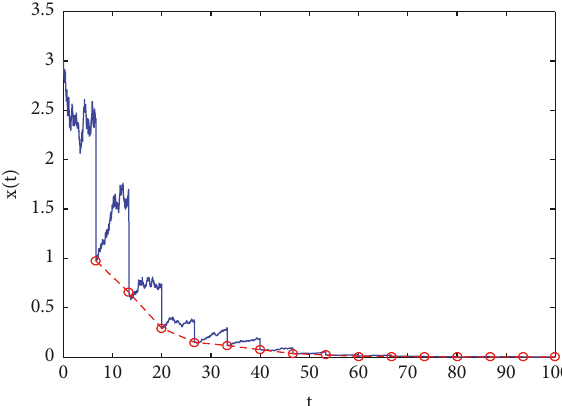
Figure 3: The pest-free solution of model (47). Parameters are fixed as 𝑟 = 0.3, 𝐾 = 2, 𝑎 = 2, 𝜇 = 0.2,𝐷 = 0.5, 𝑇 = 6.7, 𝜃 = 0.48,𝜏 = 0, 𝛼 = 0.1,𝛼 = 0.15 1 2